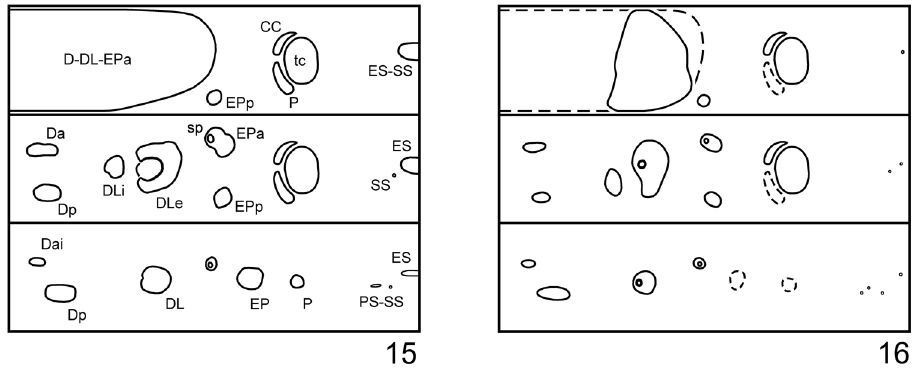
Figures 15–16. Schematic presentation of tubercular patterns (top: prothorax, middle: mesothorax, bottom: abdominal segment II), Phratora koreana . 15 first instar larva 16 third instar